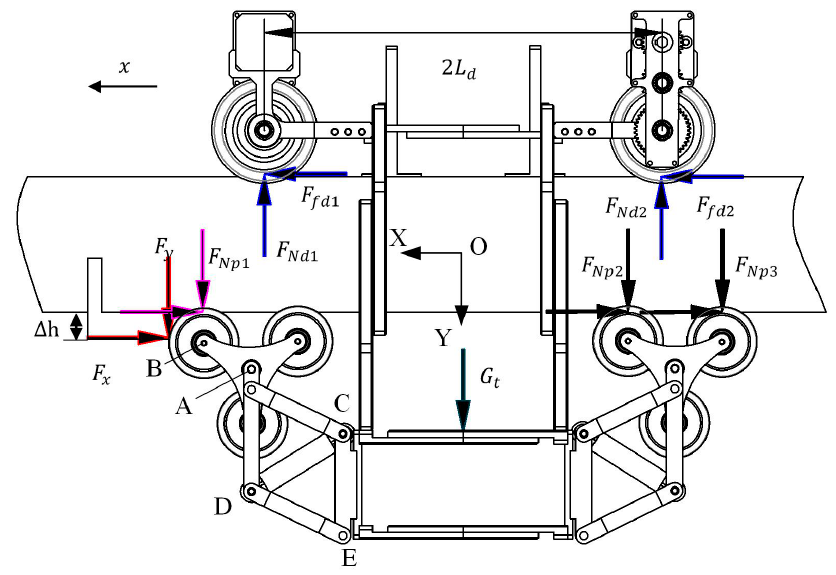
Figure 7. Force analysis of obstacle-surmounting by the pipeline-climbing robot. Table 2. Parameters in the force analysis.